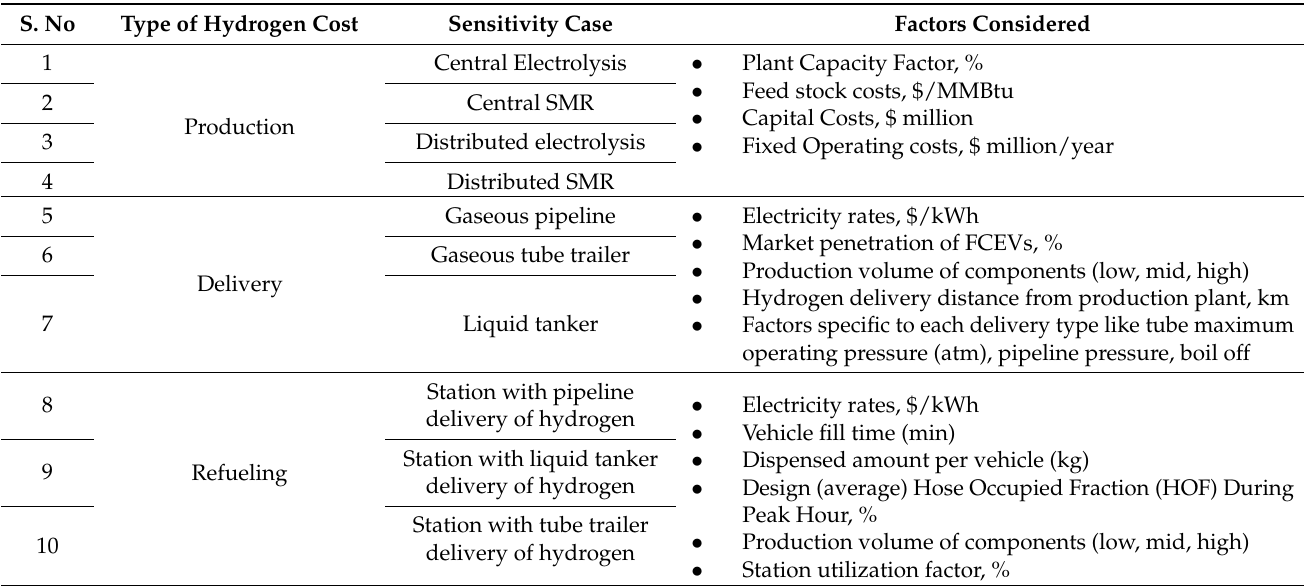
Table 5. Sensitivity analysis